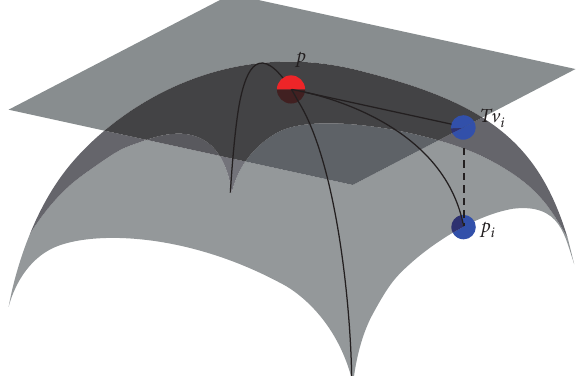
Figure 1: Illustration of Riemannian manifold and tangent space.